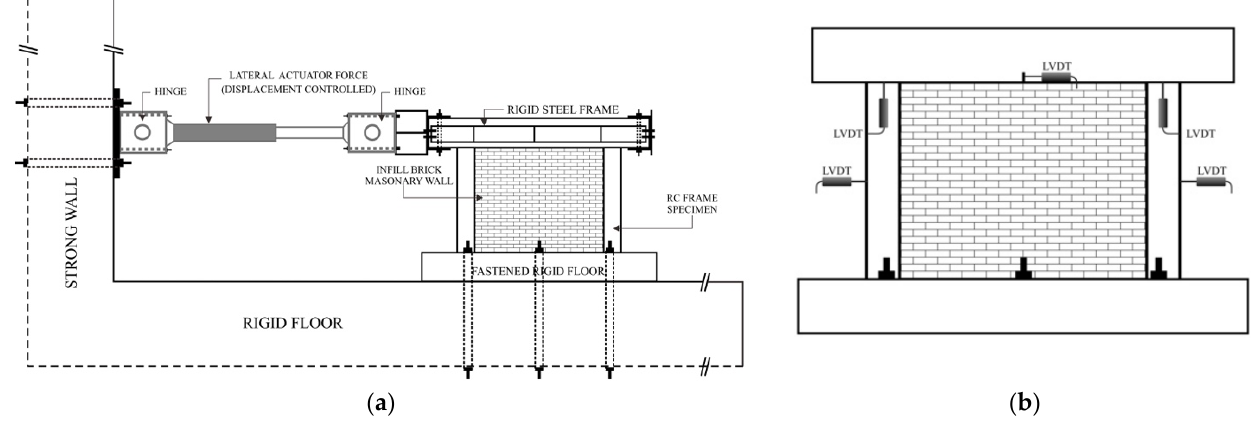
Figure 4. Schematic view of the test setup: ( a ) actuator set up and ( b ) transducer set up.